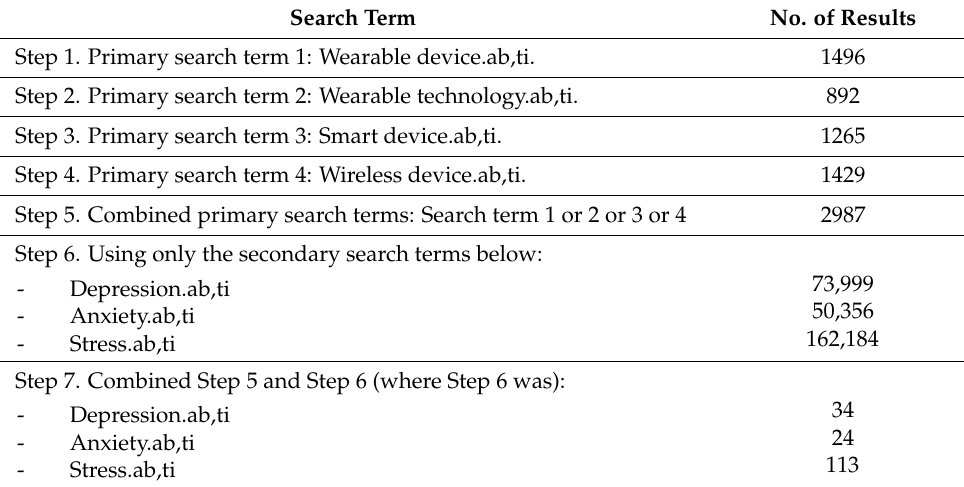
Table 1. The search structure for the MEDLINE database. Search Term